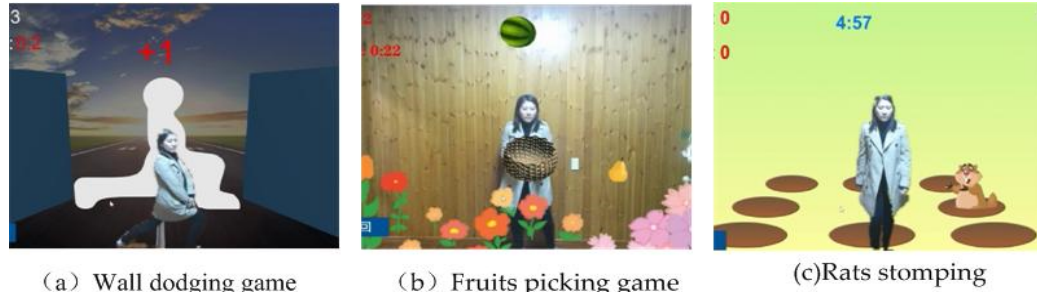
Figure 4. Three exergame interfaces.